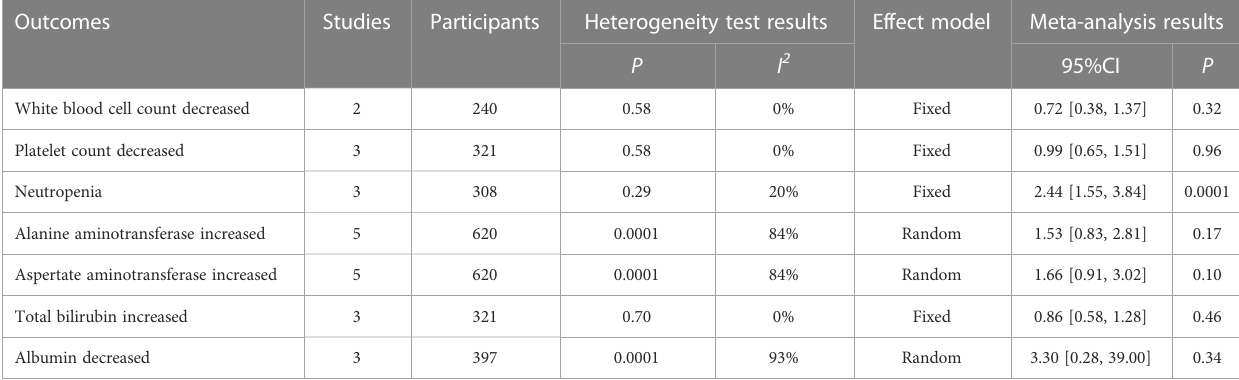
TABLE 5 Meta-analysis results of Laboratory-related